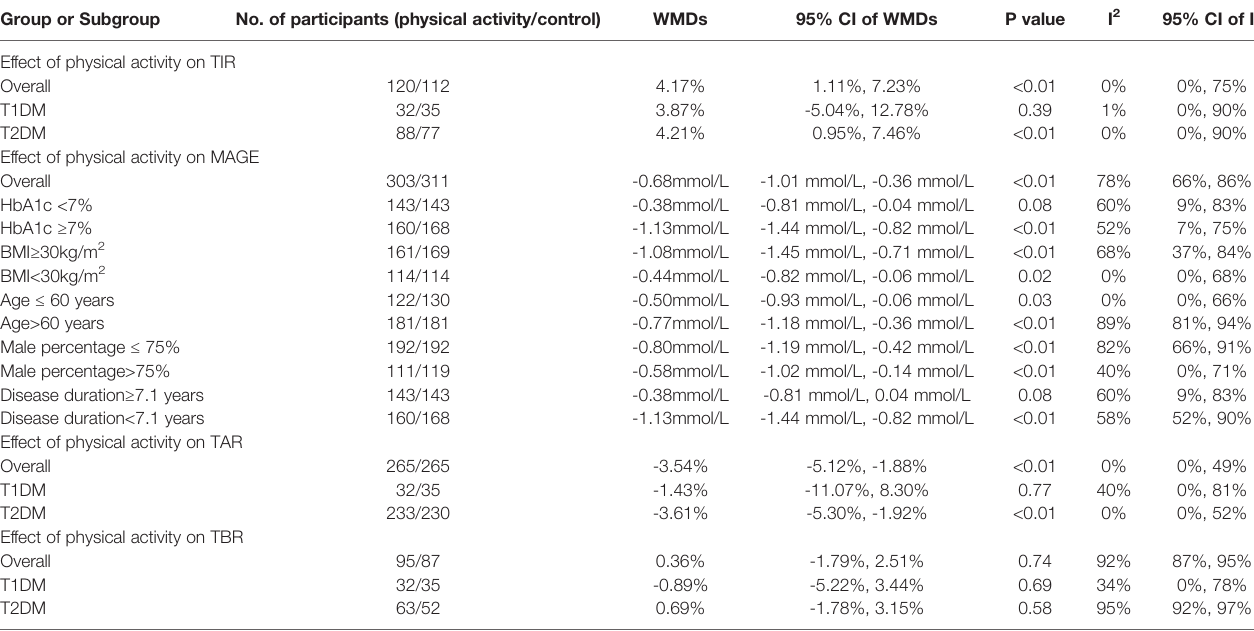
TABLE 2 | Effect of physical activity on TIR, MAGE, TAR, and TBR. Group or Subgroup